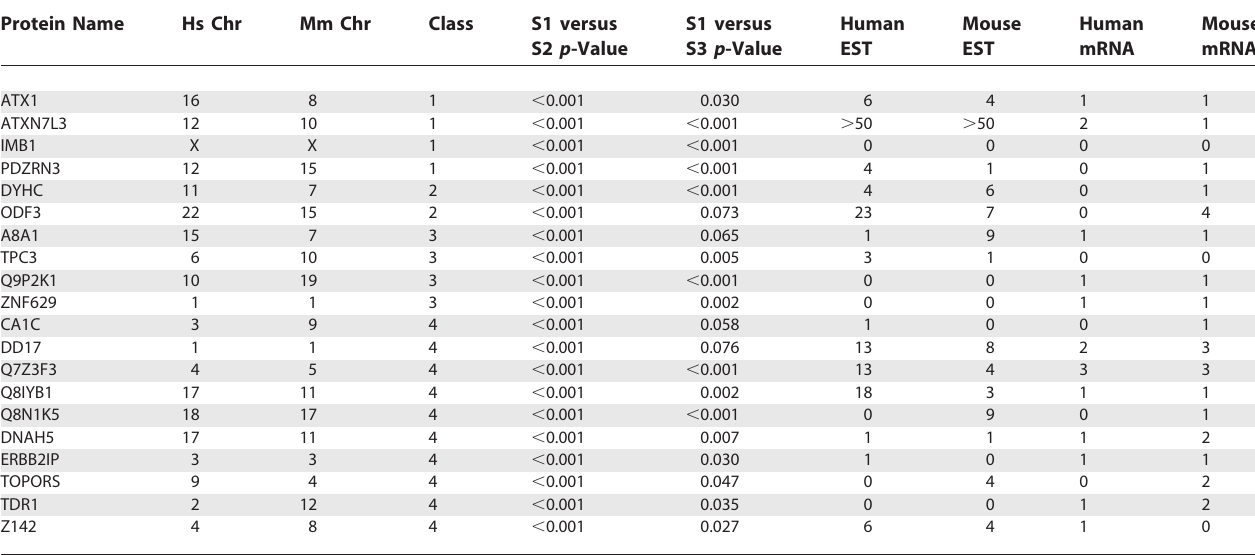
Table 3. p -Values for Scenario Comparisons and Pseudogene Expression Evidence (Number of Matching EST and mRNA Sequences) for the 20 Syntenic S 1 Quartets